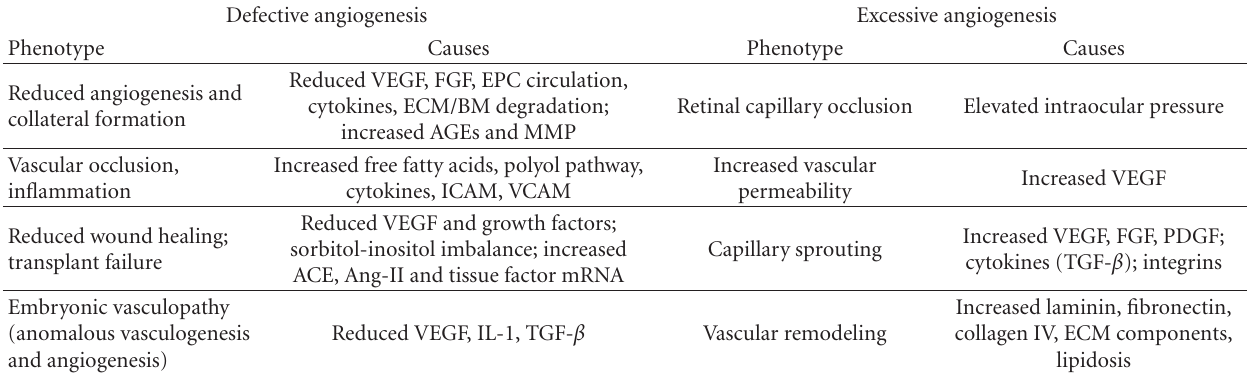
Table 1: Comparison of aberrant angiogenesis under diabetes